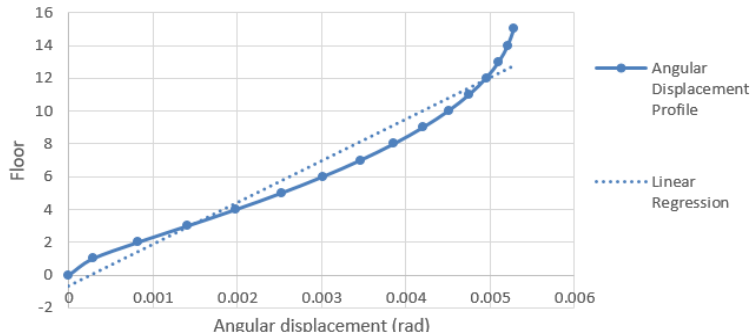
Figure 8. Angular displacement at each floor (building 4 and first analysis).